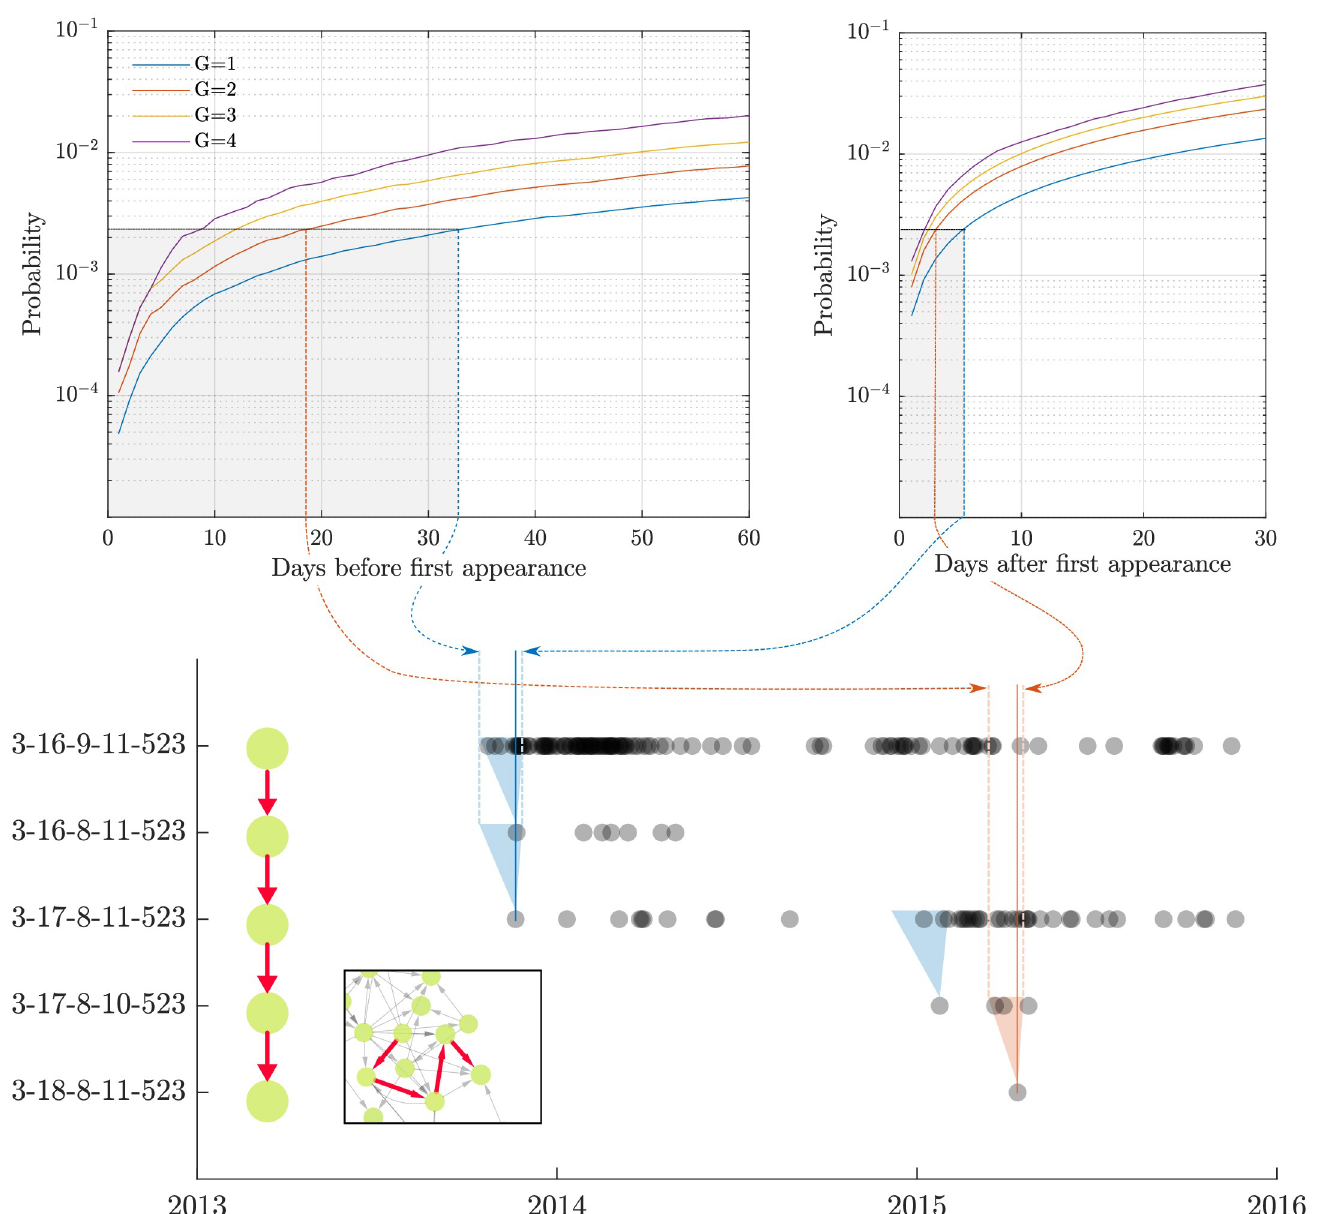
Fig 8. Inference of an evolutionary step used in constructing edges in the directed genotype network. For every genetic distance G , we use Bayesian inference to determine two temporal intervals that indicate potential evolutionary precedence. These intervals capture parent nodes that were isolated either before a child node (pre-windows) or after a child node (post-windows). The arcs in the top subfigures are cumulative probability distributions (CDFs) of these intervals for different genetic distances (number of loci modified) G . For a given level of (multiple comparisons corrected) statistical significance and genetic distance, the suitable pre- and post-windows are obtained by inverting the CDF; shown as dashed blue and red lines. Given first detection of a potential offspring MLVA profile, all nodes which are present during these intervals generate a directed edge to the offspring. The bottom subfigure illustrates inference of the four edges of the third case study, where the first three evolutionary steps crossed genetic distances of G = 1, with the final step crossing two loci ( G = 2). Shaded blue and red triangles show the corresponding temporal intervals (i.e., combined pre- and post-windows) for G = 1 (blue) and G = 2 (red), in relation to the observational data points marked by vertical solid